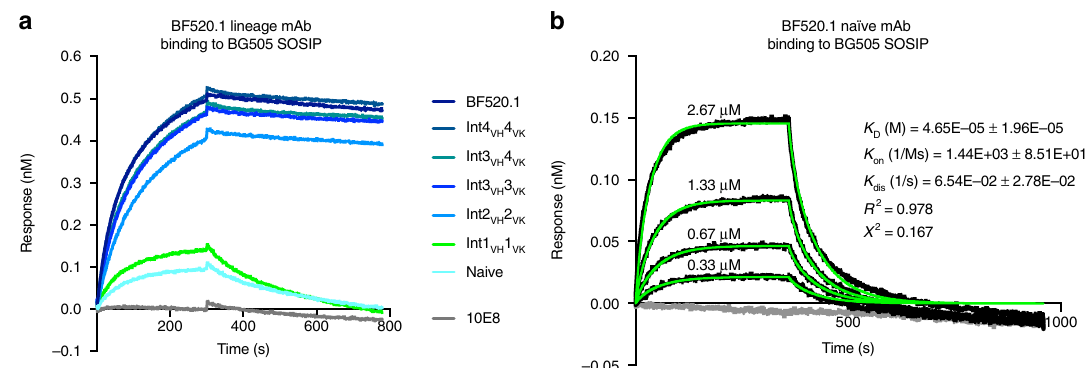
Fig. 5 BF520.1 naive and lineage binding to HIV Env trimer. a BF520.1 paired lineage intermediates (ligand) binding to the BG505.SOSIP.664 (analyte) measured by BLI. 10E8 is a negative control as the SOSIP trimer does not contain the targeted MPER epitope. Data are representative of two independent experiments. b BLI-binding analysis of varying concentrations of BF520.1 naive antibody (analyte) binding to BG505.SOSIP.664 (ligand). The gray line shows 0 μ M IgG. K D , K on , and K dis from best fi tting (green lines) to a 1:2 bivalent analyte model of ligand:analyte binding